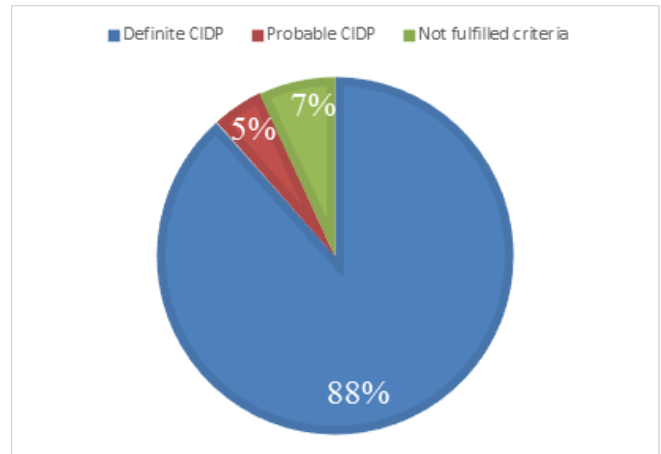
Figure 2. European Federation of Neurological Societies and the Peripheral Nerve Society